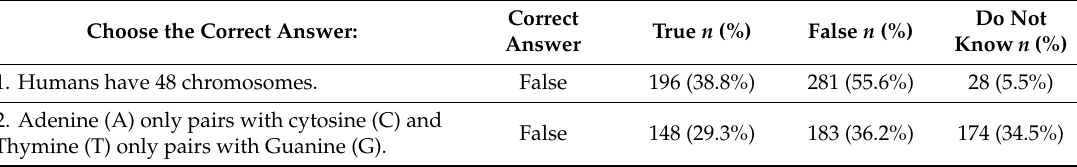
Table 2. Questions assessing pharmacogenomics and genetics knowledge among healthcare